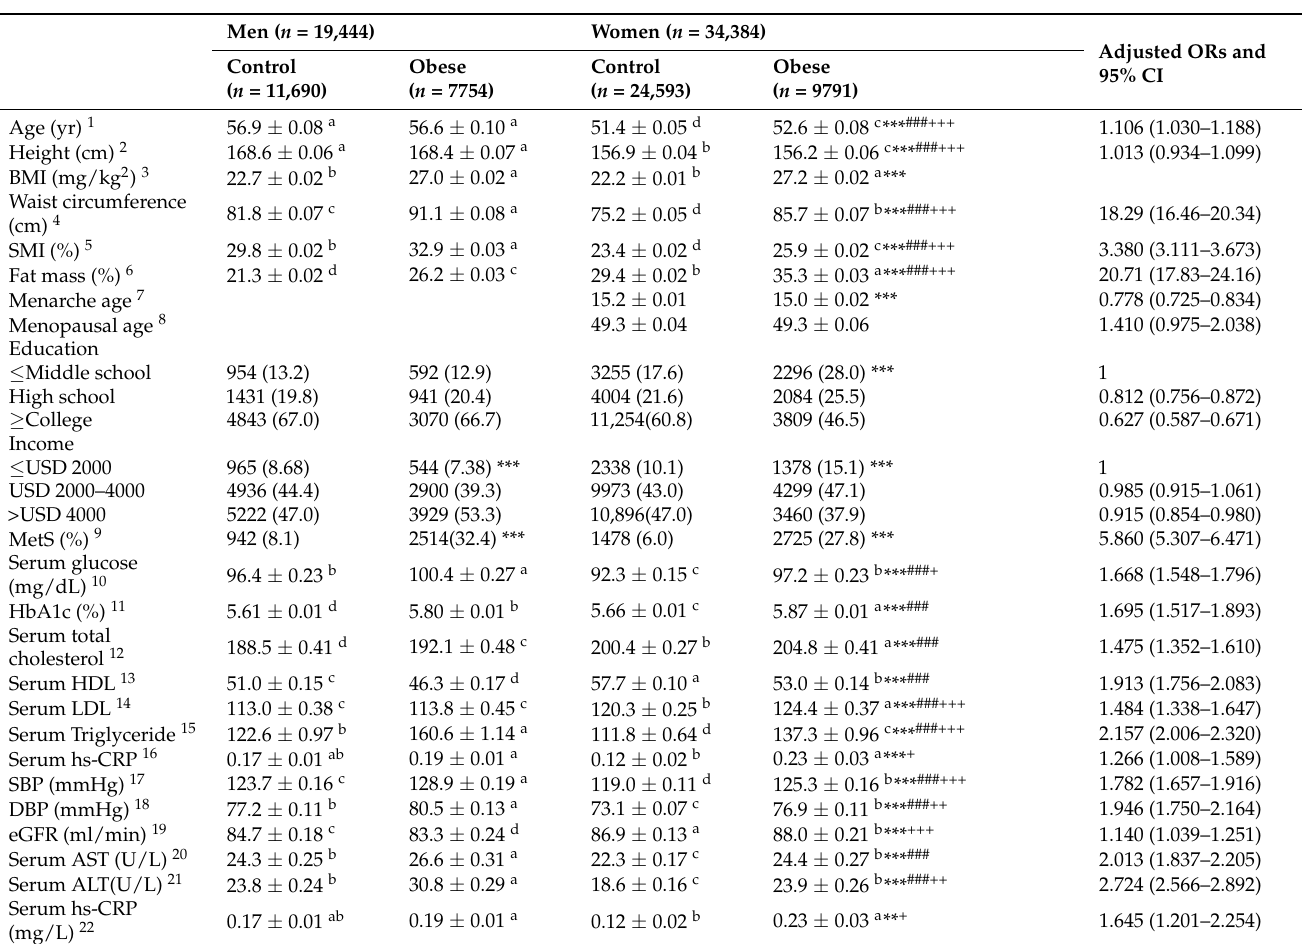
Table 1. Demographic and biochemical characteristics and association with obesity in the participants according to genders and obesity